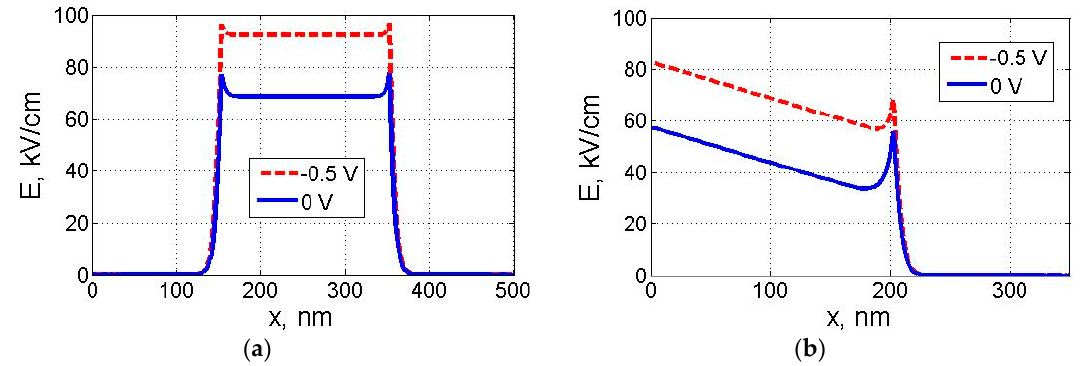
Figure 5. Spatial distributions of the electric field intensity modulus in p-i-n ( a ) and n-type Schottky-barrier ( b ) photodiodes at zero and working values of supply voltage.